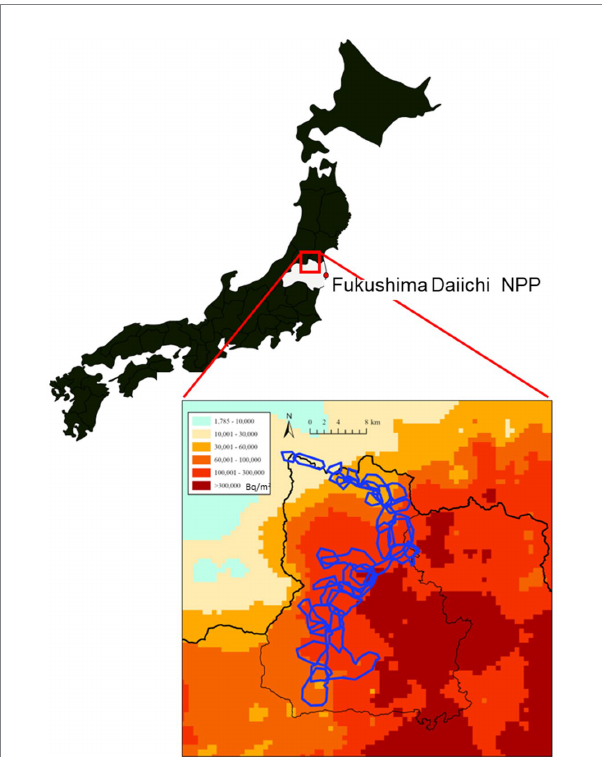
FIGURE 1 Soil contamination levels by radiocesium concentrations (Bq/m 2 ) and the distribution of monkey troops (irregular enclosed blue outlines) in Fukushima City. This map was generated according to the soil contamination map created by the Ministry of Education, Culture, Sports, Science and Technology (converted to values for July 2,